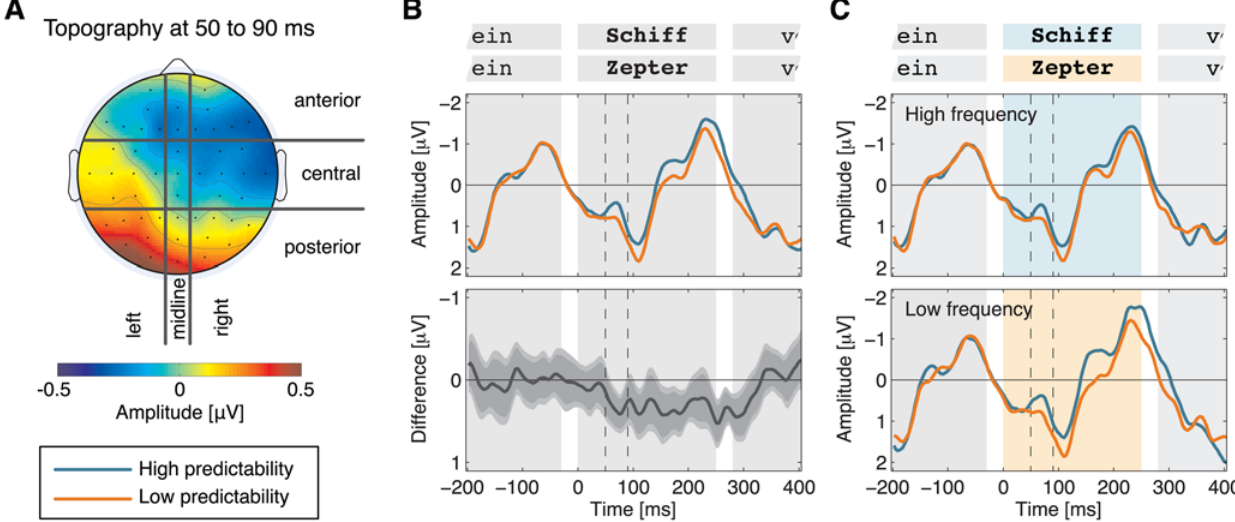
Figure 4. Predictability effect in scalp regions. (A) Topography of mean amplitude differences (low minus high predictability) in the epoch from 50 to 90 ms. Nine regions of scalp electrodes are delimited by black borders. (B) Mean amplitudes from seven electrodes at the posterior left region. In the interval from 50 to 90 ms (dashed lines), amplitudes are more negative for high (blue) than for low predictability (orange) words. The lower panel shows the difference waveform (low minus high predictability). Mid-gray and light-gray error bands depict 95% and 99% confidence intervals, respectively, computed from 5000 bootstrap samples. Background shading illustrates the stimulus sequence (gray: word present; white: blank screen). (C) Within-frequency class ERPs at the posterior left region. The early effect of predictability is independent from target frequency. Background shading reflects the stimulus sequence (shaded: word present; white: blank screen).